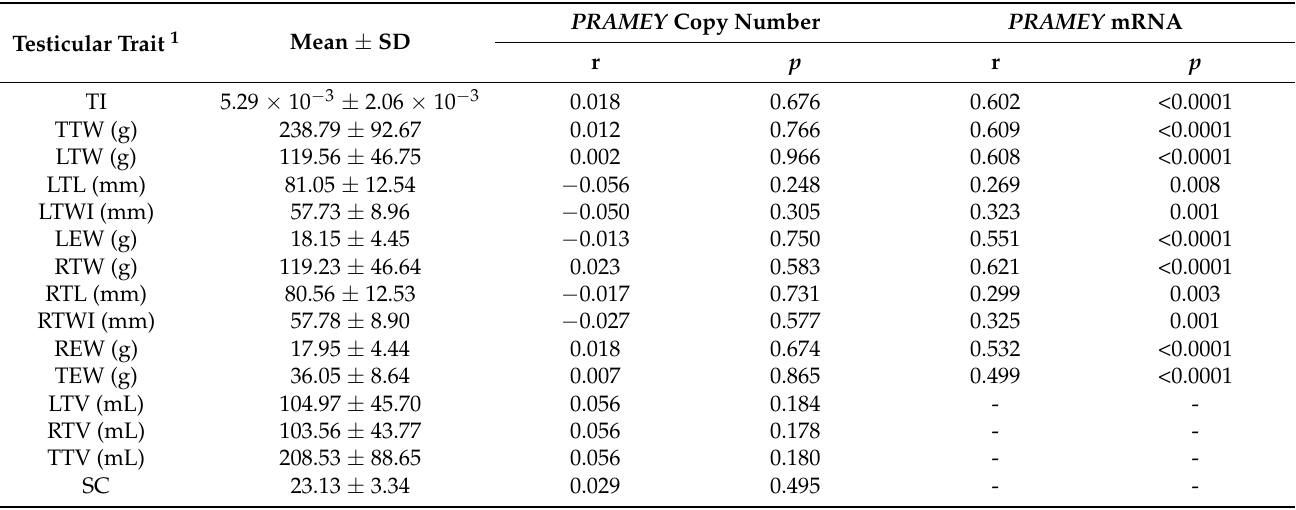
Table 3. Spearman’s correlation between the copy number and mRNA expression levels of PRAMEY and the testicular traits in Hu